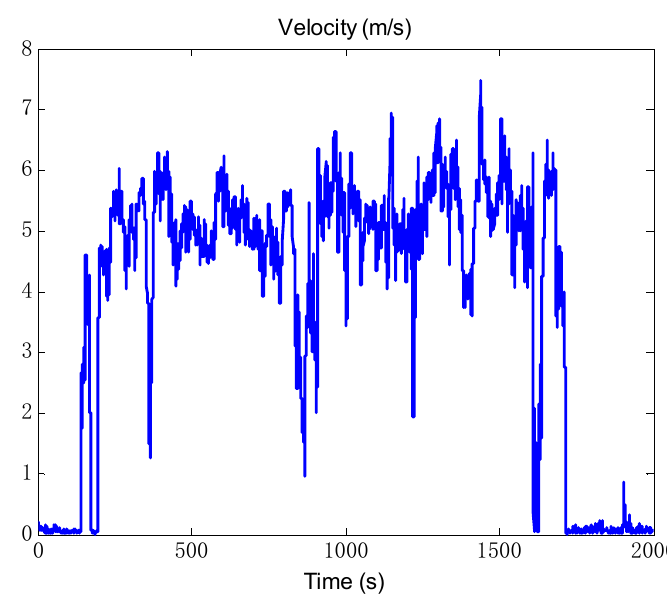
Figure 12. The vehicle test velocity measured by odometer.